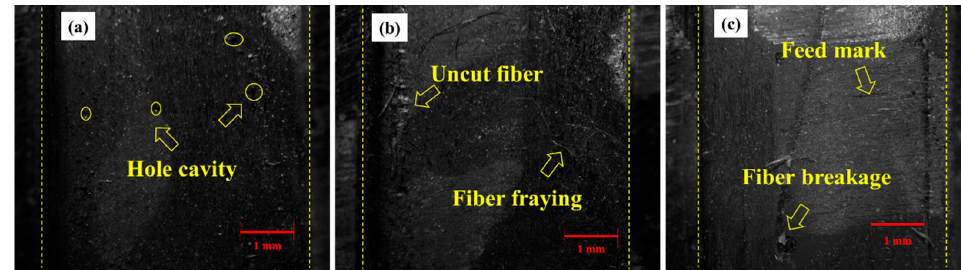
Figure 7. Microscope image of the machined slot at medium cutting speed for ( a ) 1 wt.% GO, ( b ) 2 wt.% GO, and ( c ) 3 wt.% GO.